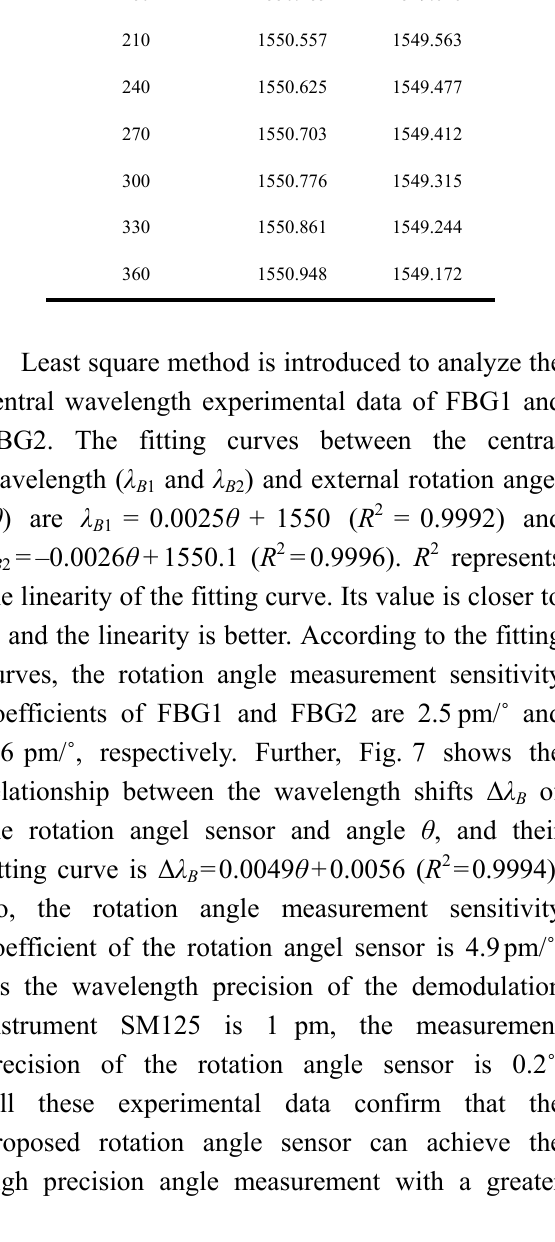
2 shows the central wavelength experimental data of FBG1 and FBG2 in the rotation angle calibration experiment when the rotation angle changes from 0 ˚ to 360 ˚ with an interval of 30 ˚ .